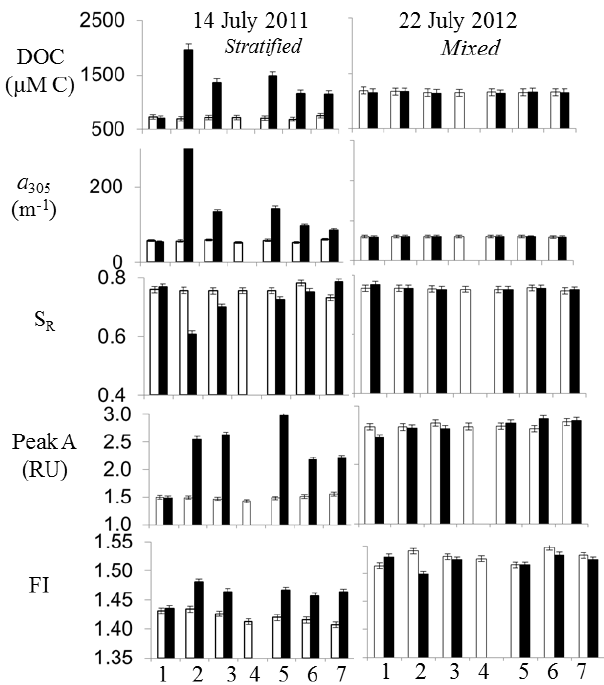
Figure 5. Concentration and quality of DOM in the surface (open bars) and bottom waters (filled bars) in pools 1-7 in Imnavait Creek under stratified (left) and mixed (right) conditions in 2011 and 2012, respectively. CDOM and FDOM concentrations shown as absorp- tion coefficients at 305nm ( a 305 ) and emission intensities at Peak A (Raman Units; RU), respectively. DOM quality shown as slope ratio ( S R ) and fluorescence index (FI); CDOM and FDOM proxies for DOM described in